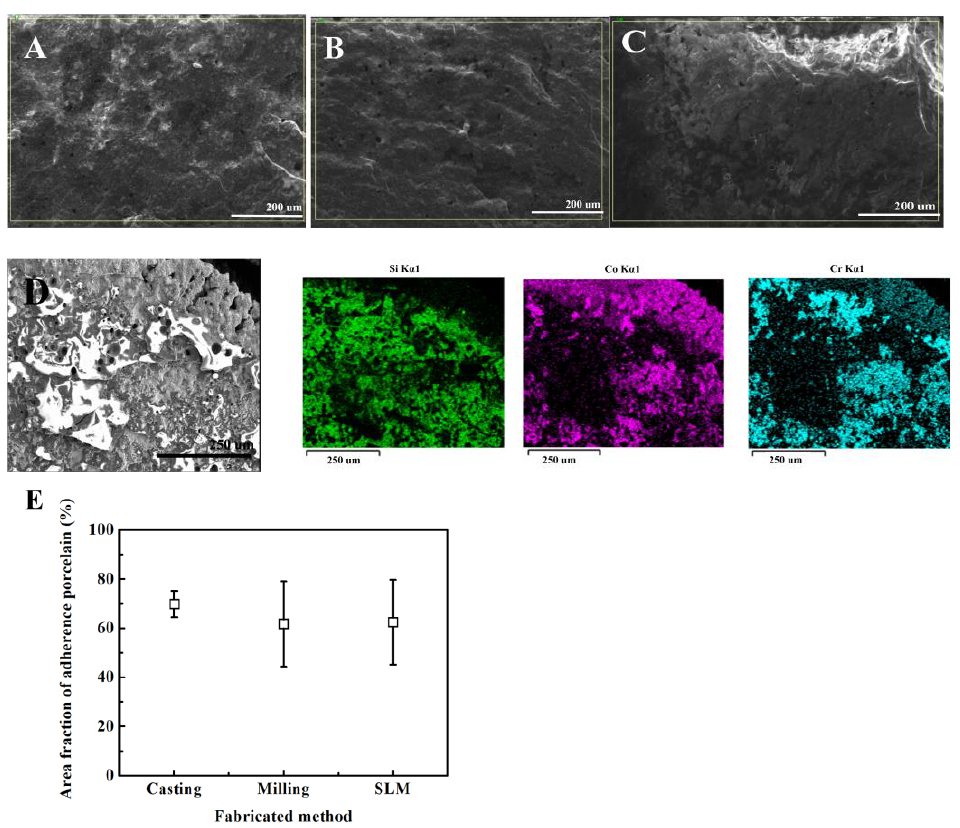
Figure 5. SEM and EDX results (× 200 magnification) of casting, milling, SLM specimen metal–ceramic interface after fracture experiment. ( A ) casting, ( B ) milling, ( C ) SLM, ( D ) EDX mapping data on the metal–ceramic interface after fracture experiment. ( E ) area fraction of adherence porcelain values following different manufacturing techniques.